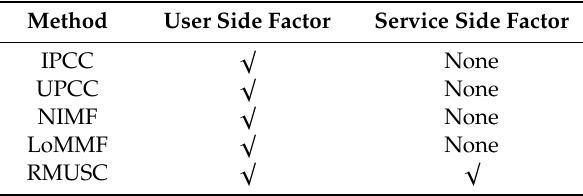
Table 2. Comprehensive factors of di ff erent recommendation models.